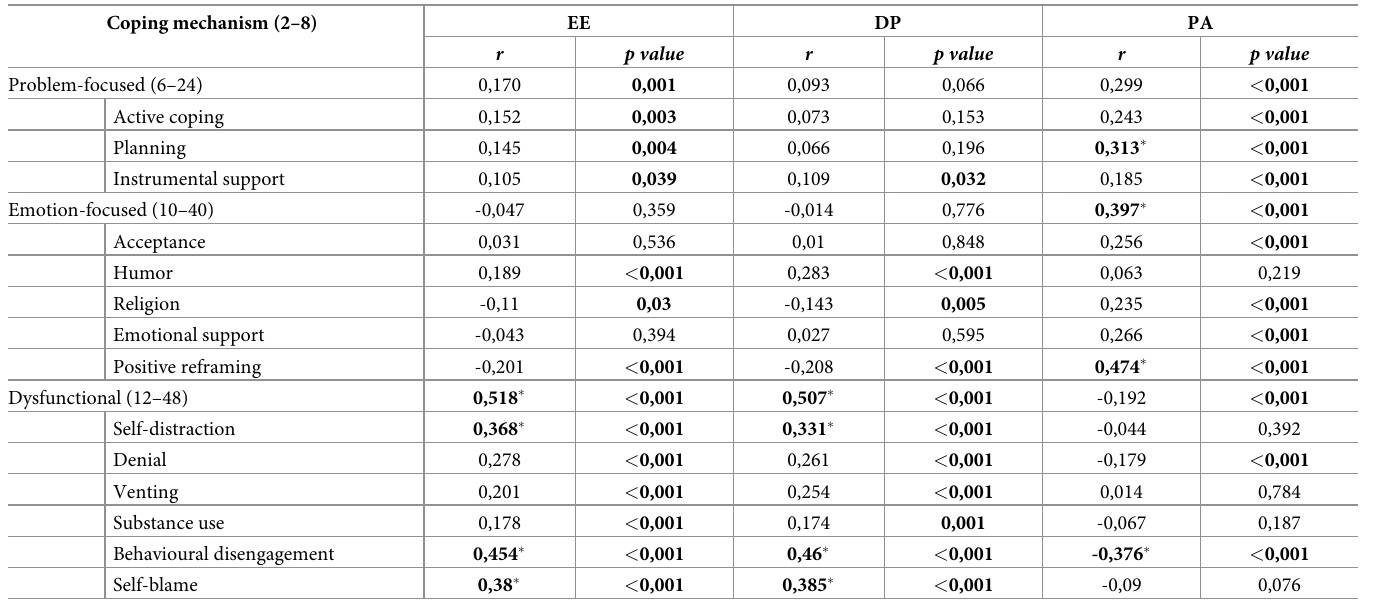
Table 3. Correlation between coping mechanism and burnout